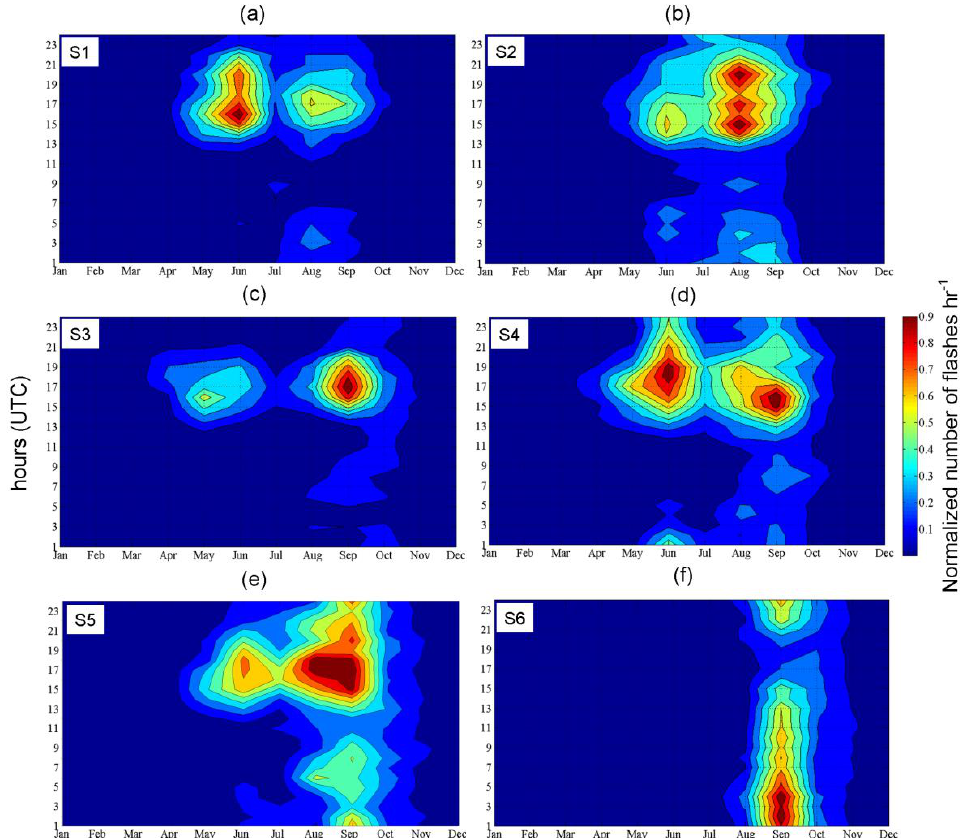
Figure 3: As in Fig. 2, but now for the following subsectors in IS (cf. Fig. 1): (a) North 797 Fig. 3. As in Fig. 2, but now for the following subsectors in IS (cf. Fig. 1): (a) north (S1), (b) Pyrenees (S2), (c) western Iberian (S3), (d) central Iberia (S4), (e) eastern Iberia (S5), and (f) Balearic Islands (S6). Values are normalized to unit maximum in each (S1); (b) Pyrenees (S2); (c) Western Iberian (S3); (d) Central Iberia (S4); (e) Eastern 798 Iberia (S5); and (f) Balearic Islands (S6). Values are normalized to unit maximum in 799 each diagram. 800